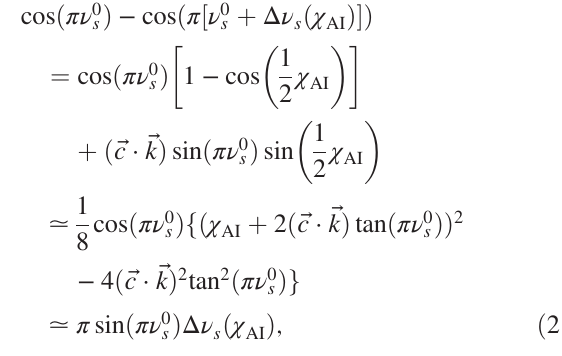
the location RF